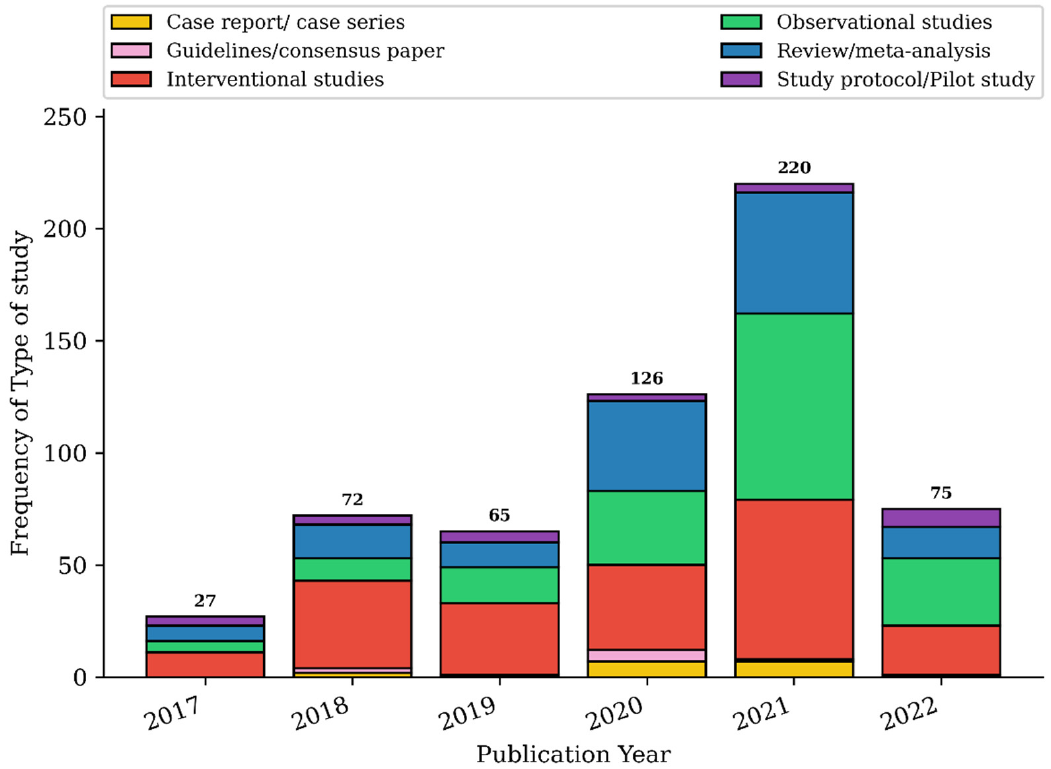
Figure 3. Frequency of type of studies according to publication year.